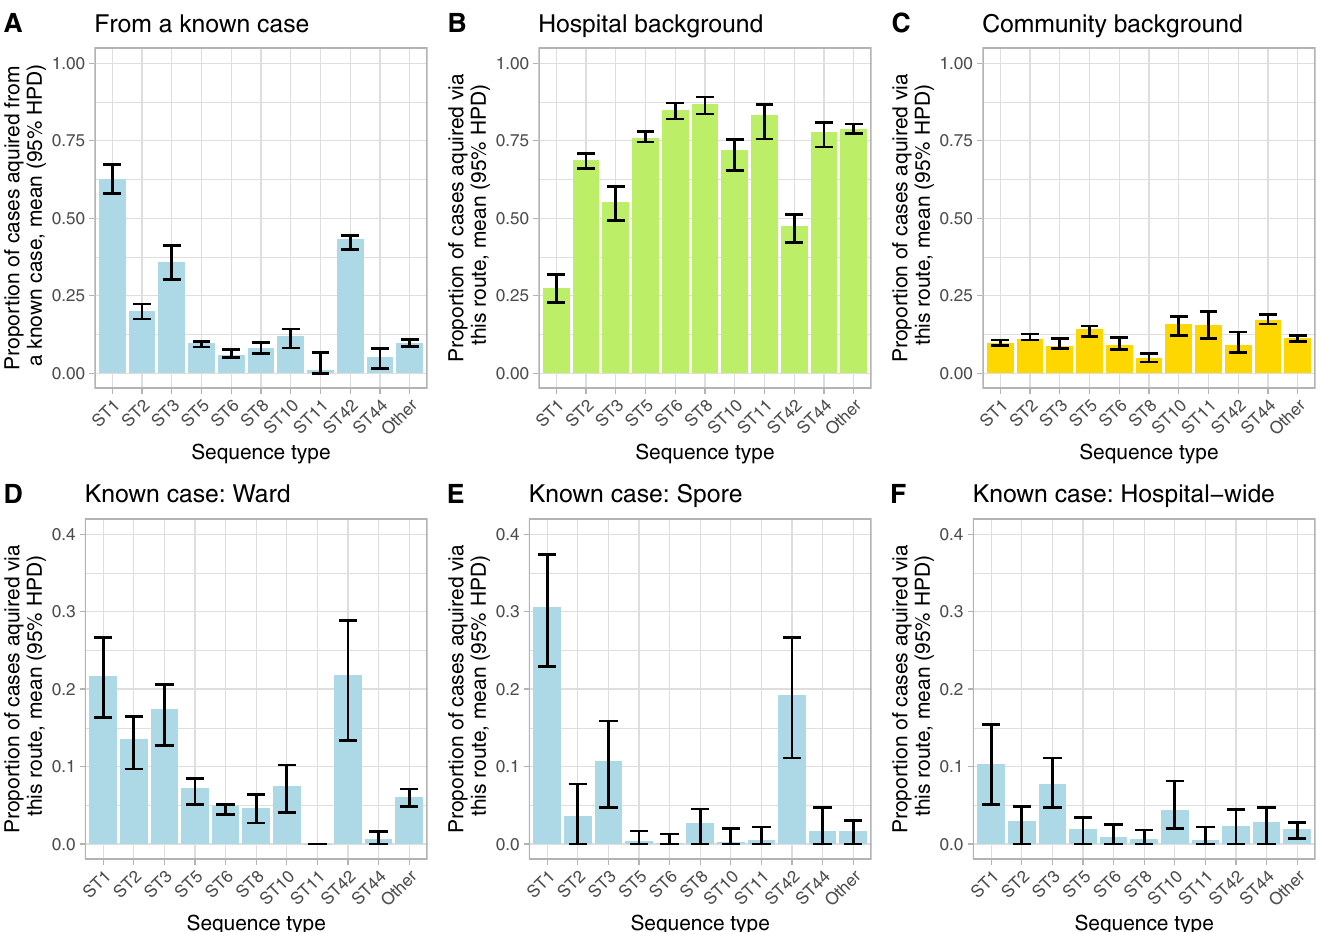
Fig 5. Proportion of cases acquired from each transmission route, by sequence type. Panels A to C show the estimated proportion of cases acquired from each of the 3 major source types, known patients (A, blue), hospital background sources (B, green) and the community (C, gold). Panels D to F subdivide the cases shown in panel A, into those acquired by direct ward contact (D), ward-based spores (E) and hospital-wide transmission (F). Note the y-axis scale differs between the upper panels and lower panels, to allow for comparison of the relative contribution of ward, spore and hospital-wide routes to transmission from other cases, and hospital vs. community for background